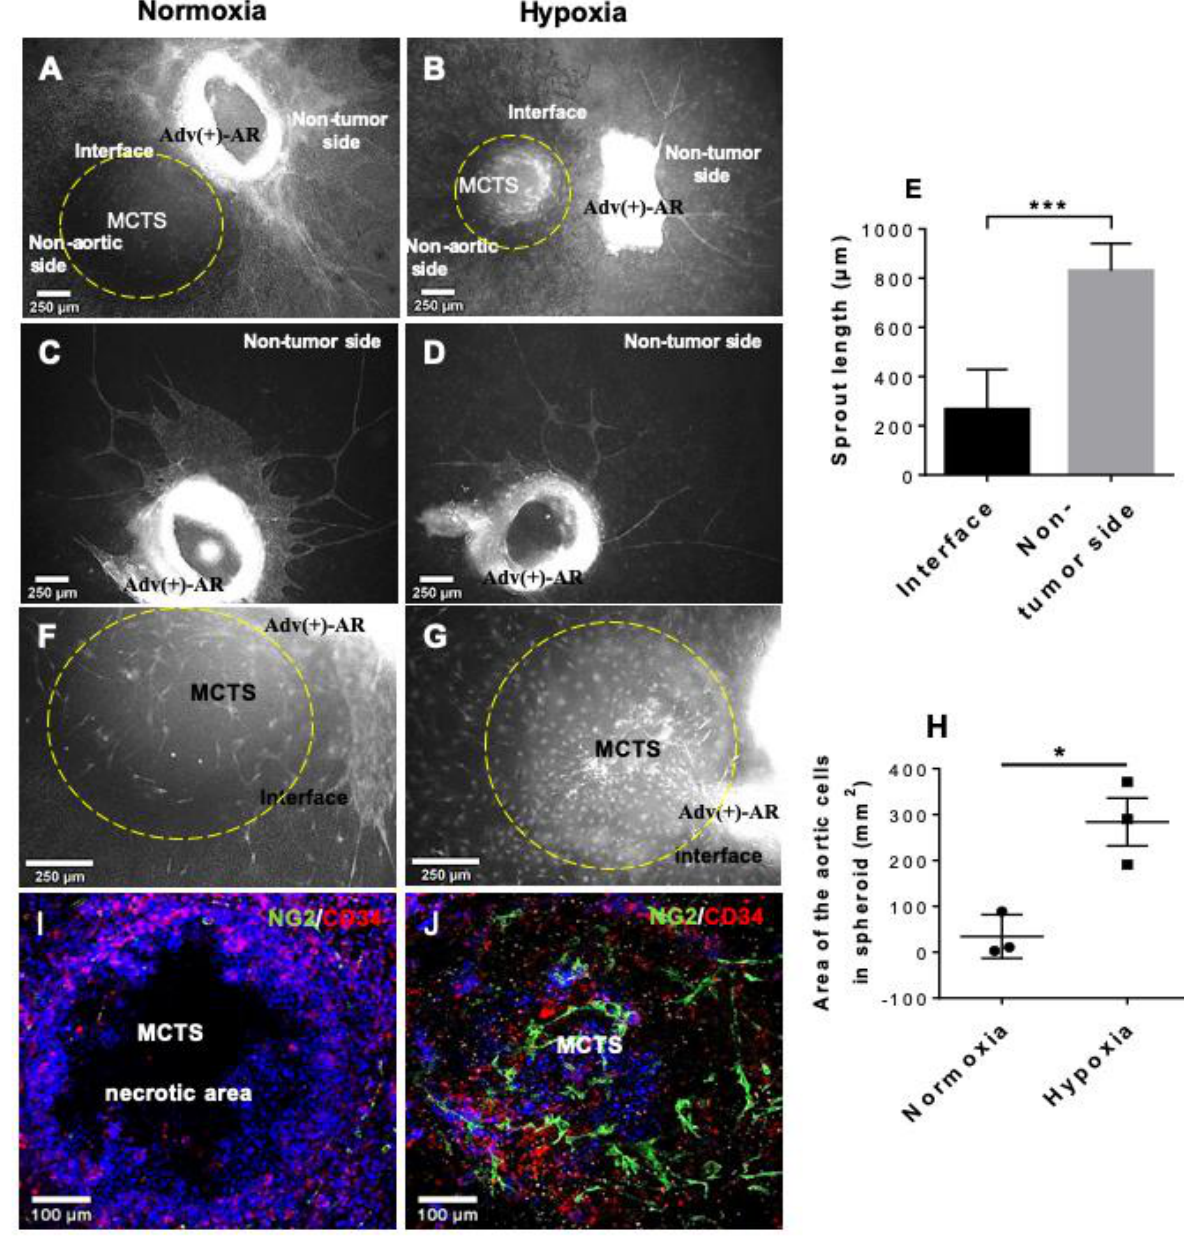
Figure 4. 3D MCTS confrontation model with ARs from GFP + mouse aorta (AR-MCTS). MCTS confrontation with ARs cultivated for 11 days in collagen gel under normoxic ( A ) or hypoxic conditions ( B ). Aortic cells were GFP marked. At the non-tumor side, angiogenic sprouting occurred under normoxia and hypoxia ( C , D ), whereas in the interface, sprouting was only observed under hypoxia ( B ). Quantification of the sprouts ( E ). Sprouting towards the MCTS is observable after 11 days of confrontational cultivation under normoxic ( F – I ), and hypoxic conditions ( G – J ). Under normoxia, few NG2 + aortic cells only scarcely surrounded the MCTS without penetrating the spheroid ( I ). Under hypoxia, more NG2 + cells were mobilized from the AR, forming a dense network within the MCTS ( J ). Quantification from F and G ( H ). Error bars indicate SD. * p ≤ 0.05, *** p ≤ 0.001.